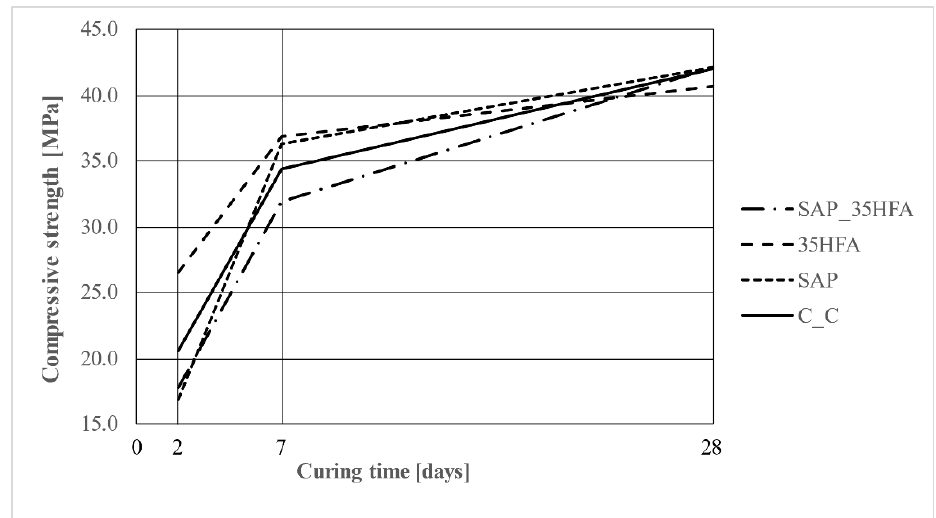
Figure 18. Compressive strength after 2, 7 and 28 days of curing.